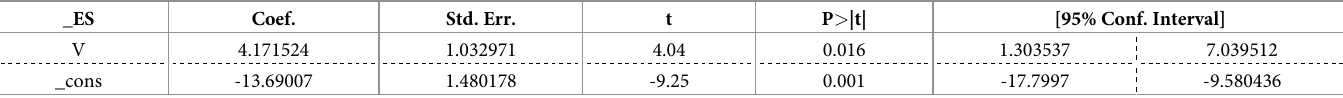
Table 3. Meta-regression of different bilirubin levels. _ES Coef. Std. Err.